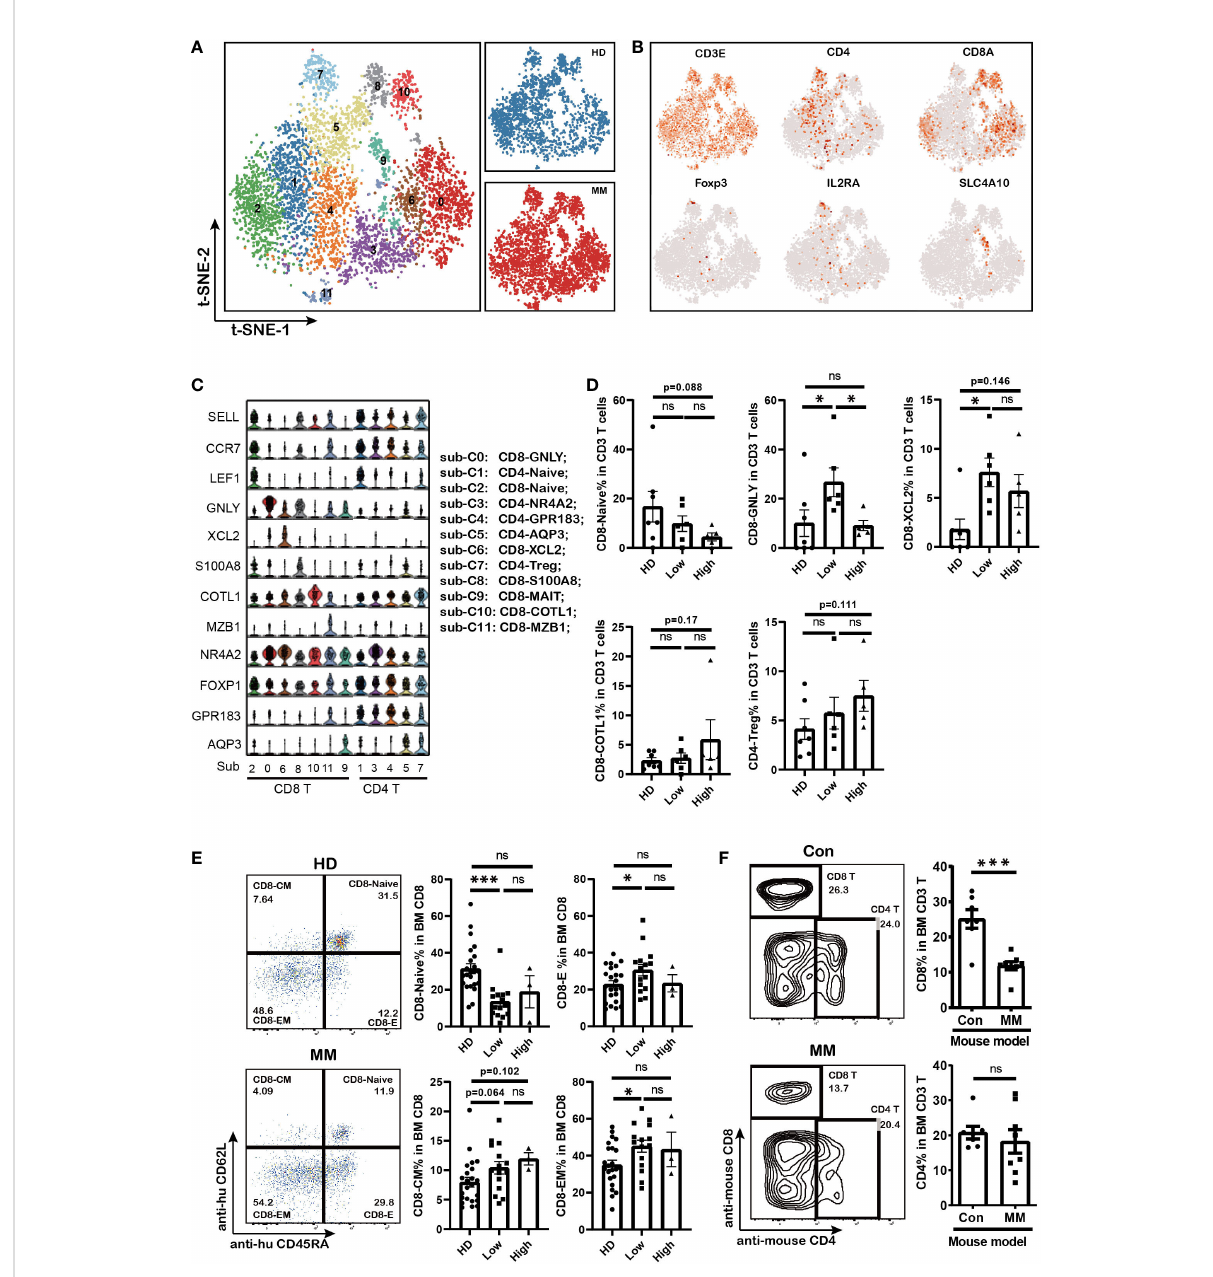
FIGURE 2 The fl uctuation of CD8 effector T cells and accumulation of CD8 memory T cells in MM patients with different tumor burden (A) . t-SNE shows the T cell sub-clusters in HD and MM patients. Cells with a high level of CD3 ( CD3E , CD3G and CD3D ) expression were T cells. Each dot represents a single cell; colors indicate cell clusters with numbered labels. (B) .t-SNE plot show the expression and distribution of classical cell markers of T cell sub-clusters. Color intensity indicates expression level of selected genes. (C) .Violin charts show the expression of classical cell markers of T cell sub-clusters. The sub-cluster numbers in (c) bottom correspond to the ones in (A) . Sub-C0: CD8-GNLY (effector T cells); sub- C1: CD4-Naïve; sub-C2: CD8-Naive; sub-C3: CD4-NR4A2; sub-C4: CD4-GPR183_FOXP1; sub-C5: CD4-AQP3; sub-C6: CD8-XCL2 (memory T cells); sub-C7: CD4-Treg; sub-C8: CD8-S100A8; sub-C9: CD8-MALT; sub-C10: CD8-COTL1; sub-C11: CD8-MZB1; (D) . Bar charts show the proportions of T cell sub-clusters from HD and different in fi ltration groups of MM patients. (HD: n=7; Low: n=6; High: n=6) (E) . Flow cytometry analysis shows the proportions of CD8+ T cell sub-populations in HD and MM patients. (HD: n=23; Low: n=15; High: n=3) CD8-Naive: CD3 + CD8 + CD45RA + CD62L + ; CD8-Effector: CD3 + CD8 + CD45RA + CD62L - ; CD8-Central memory: CD3 + CD8 + CD45RA - CD62L + ; CD8-Effector memory: CD3 + CD8 + CD45RA - CD62L - ; (F) . Flow cytometry analysis and bar charts show the proportion of CD8 T and CD4 T cells in Control and 5TGM1 MM mouse model (Control: n=7; MM: n=8). In all instances, p < 0.05 was considered signi fi cant, * p < 0.05 and *** p < 0.001. ns, no signi fi